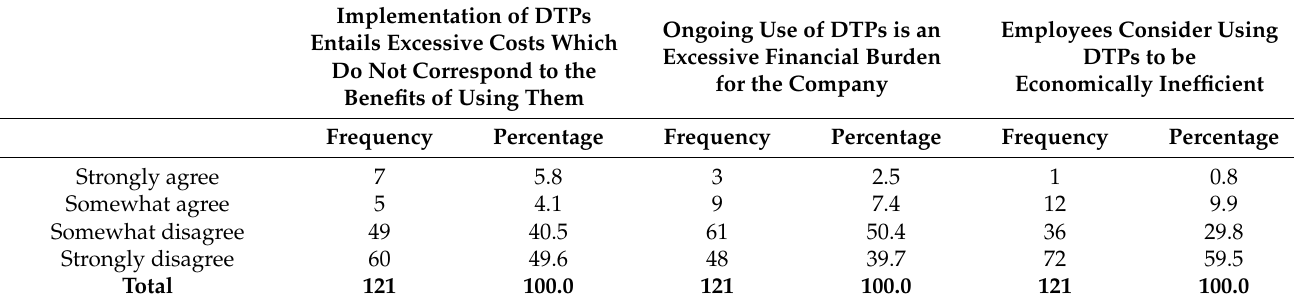
Table 5. Implications of DTP implementation.